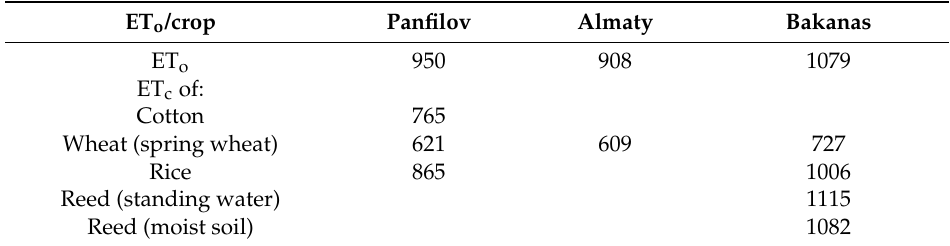
Table 5. Reference evapotranspiration (ET o ) and crop evapotranspiration (ET c ) according to [35] based on monthly climate data from stations Panfilov, Almaty, and